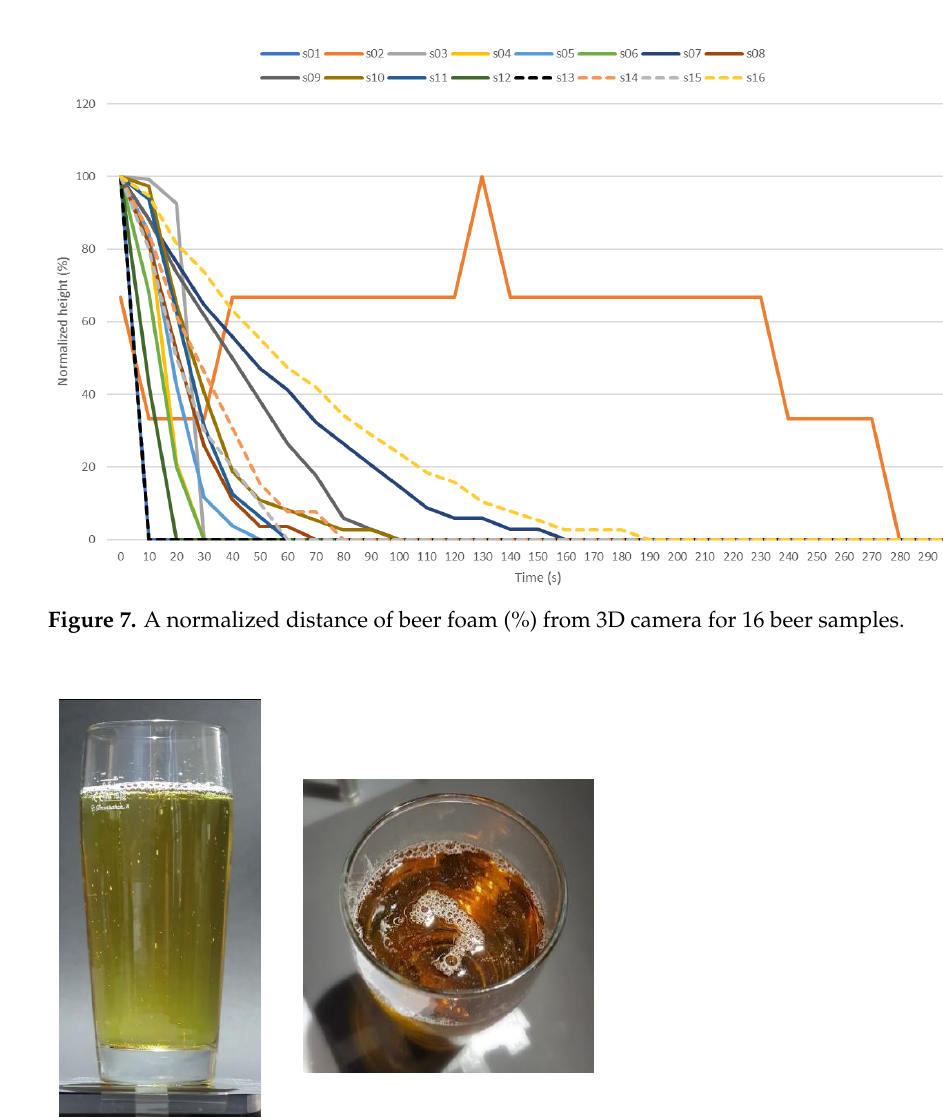
Figure 8. Sample s06 after 40 s. ( a ) Foam is detected by automated image analysis of RGB image, even though this is just foam clinging to the beer glass; ( b ) 3D camera records this as lack of foam.